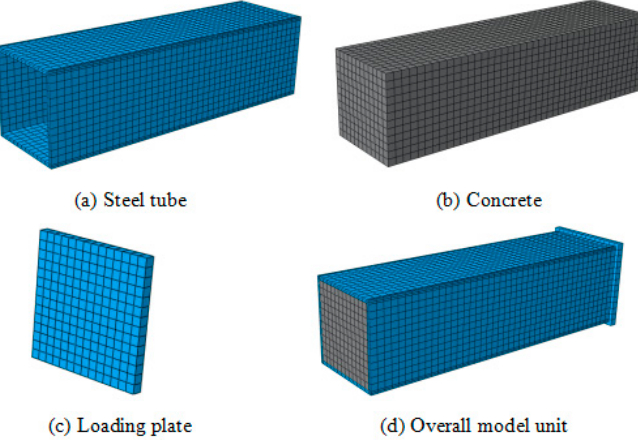
Figure 2. Schematic diagram of model